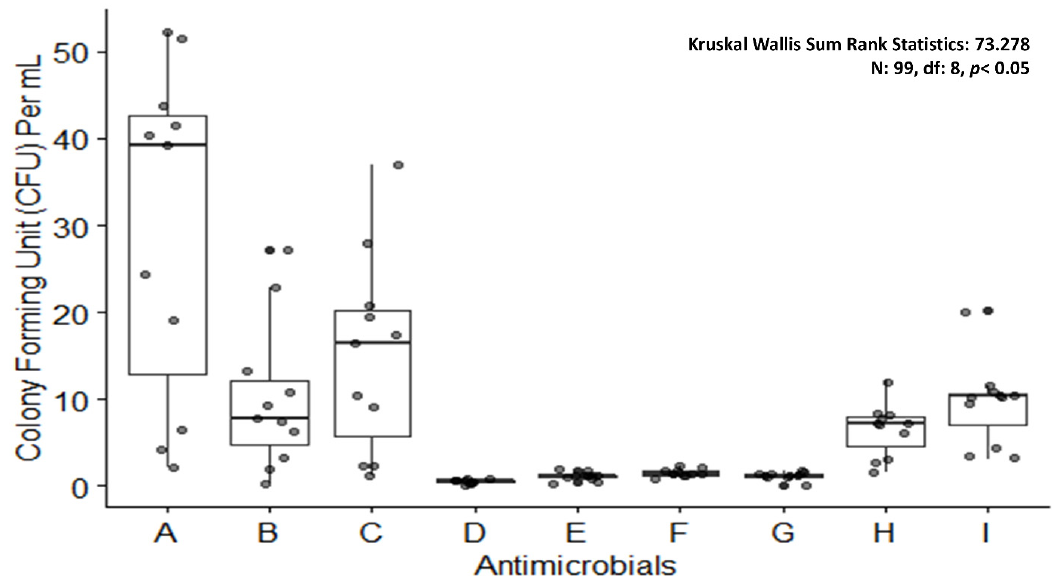
Figure 8. Boxplot showing colony forming units upon treating Enterococcus faecalis biofilm with an- timicrobials. A : control; B : silver nanoparticles 20 µg/mL; C : silver nanoparticles 10 µg/mL; D : silver timicrobials. A : control; B : silver nanoparticles 20 µ g/mL; C : silver nanoparticles 10 µ g/mL; D : silver nanoparticles 20 µg/mL and clove 2500 µg/mL combination; E : silver nanoparticles 10 µg/mL and nanoparticles 20 µ g/mL and clove 2500 µ g/mL combination; E : silver nanoparticles 10 µ g/mL and clove 1700 µg/mL combination; F : silver nanoparticles 5 µg/mL and eugenol 850 µg/mL combina- clove 1700 µ g/mL combination; F : silver nanoparticles 5 µ g/mL and eugenol 850 µ g/mL combination; tion; G : sodium hypochlorite 5%; H : sodium hypochlorite 3; I : chlorhexidine 2%. G : sodium hypochlorite 5%; H : sodium hypochlorite 3; I : chlorhexidine